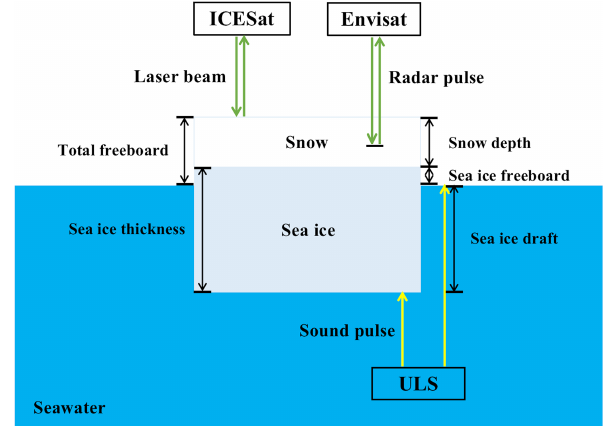
Figure 1. An illustration of measuring freeboard using ICESat and Envisat and the ULS measurement principle. Note that radar altime- ter on Envisat usually penetrates to somewhere between the air– snow and snow–ice interfaces (Willatt et al., 2010), which is one of the main sources of Envisat SIT